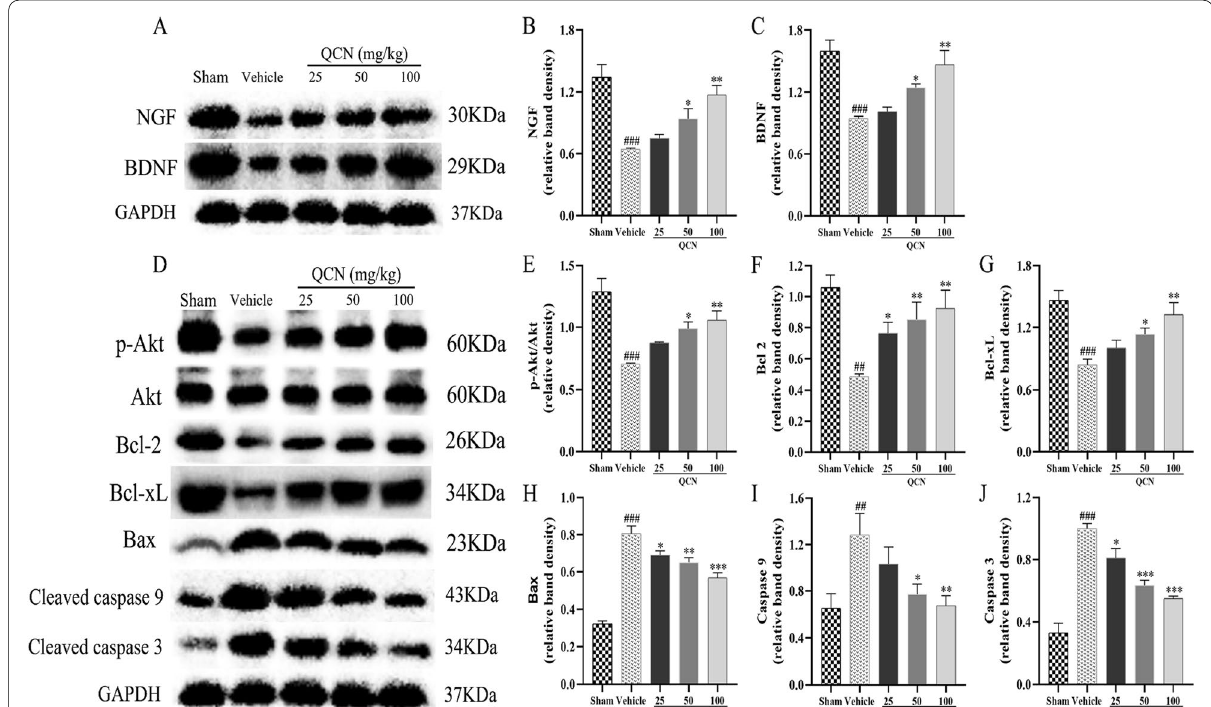
Fig. 7 Effects of QCN on neurotrophins and Akt signaling pathway in the spinal cord of the BPA rats at week 8 post‑avulsion. A The protein levels of BDNF and NGF as determined by western blot. Quantification of B BDNF and C NGF protein in the ventral horn of the C6–7 spinal segments. D The protein levels of p‑Akt, Bcl‑2, Bcl‑xL, Bax, Caspase‑9, and Caspase‑3 as determined by western blot. Quantification of E p‑Akt/Akt, F Bcl‑2, G Bcl‑xL, H Bax, I cleaved caspase‑9, and J cleaved caspase‑3 proteins in the ventral horn of the C6–7 spinal segments. Data are expressed as the mean ( n 3). ### p < 0.001 vs the sham group; * p < 0.05, ** p < 0.01, and *** p < 0.001 vs the vehicle =